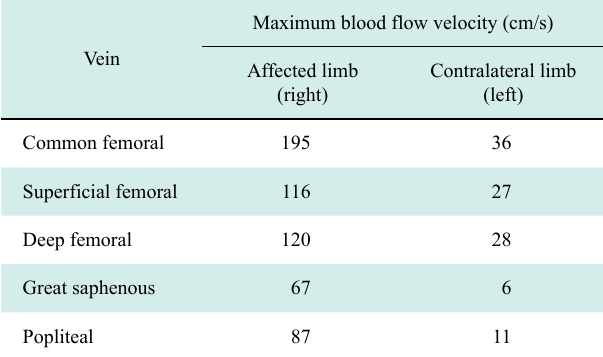
Table 4 Changes in venous blood flow velocity in the lower limbs